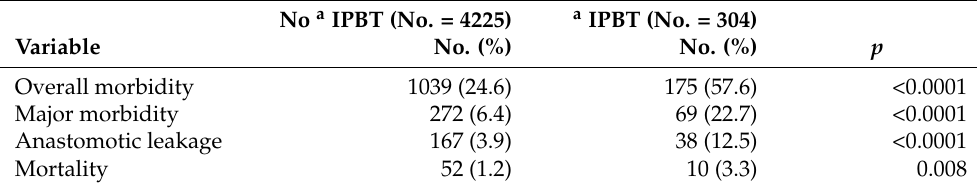
Table 2. Comparative analysis of outcomes in the two